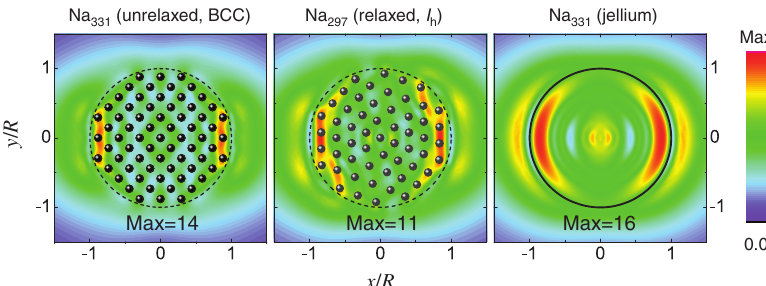
, ICO Na , and jellium Na clusters at the corresponding Mie LSP resonance. The E -field 331 297 331